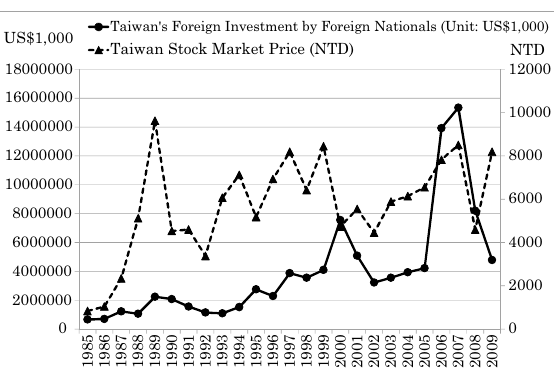
Fig. 2. Taiwan’s foreign investment by foreign nationals (unit: uS$1,000) and Taiwan stock market price (NTD) from 1985–2009 Data: Taiwan Investment Commission (MoEA) (www.moeaic.gov.tw) and